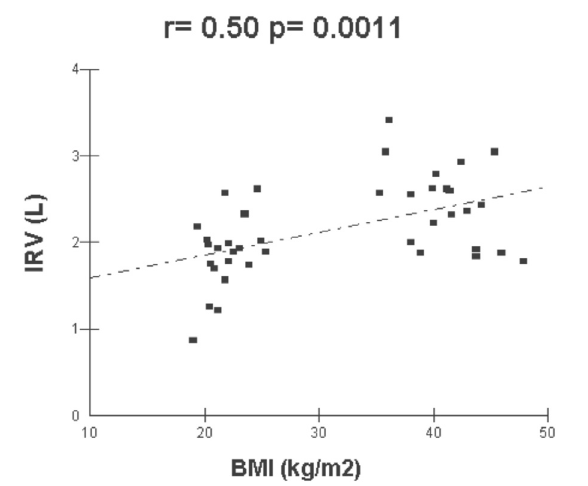
Figure 2 - Correlation between the body mass index (BMI) and the expira- tory reserve volume